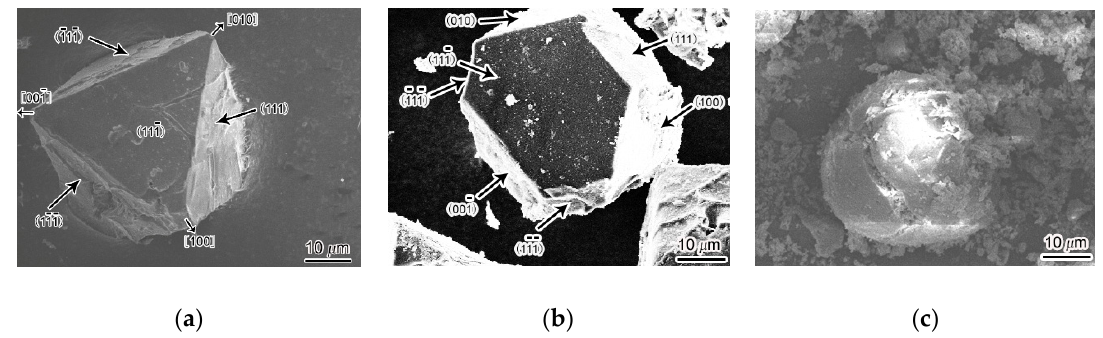
Figure 3. ( a ) Octahedral morphology and ( b ) tetrakaidecahedral morphology of Mg 2 Si crystals extracted from Mg 2 Si–Al composites prepared by gravity casting and ( c ) spherical morphology of an Mg 2 Si crystal extracted from Mg 2 Si–Al composite prepared by semi-solid extrusion with an isothermal heat treatment holding time of 160 min.